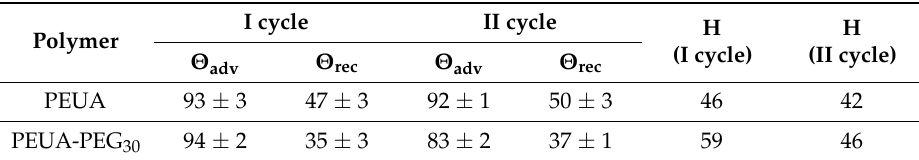
Figure 8. Stress ‐ strain curves of PEUA and PEUA ‐ PEG 30 . As it can be observed, both polymers showed an elongation at a break of ca. 10. The Young Modulus, determined from the slope of the initial linear trend, was also similar for the two polymers (E PEUA = 0.9 MPa e E PEUA ‐ PEG30 = 0.7 MPa). However, the trend of the two stress–strain curves was very